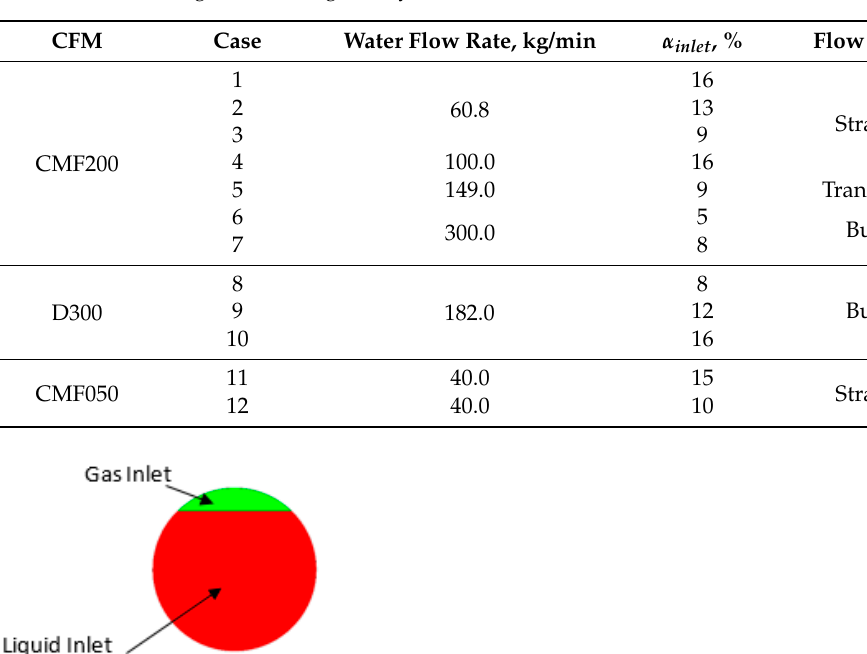
Table 2. The flow regimes investigated by numerical simulation.